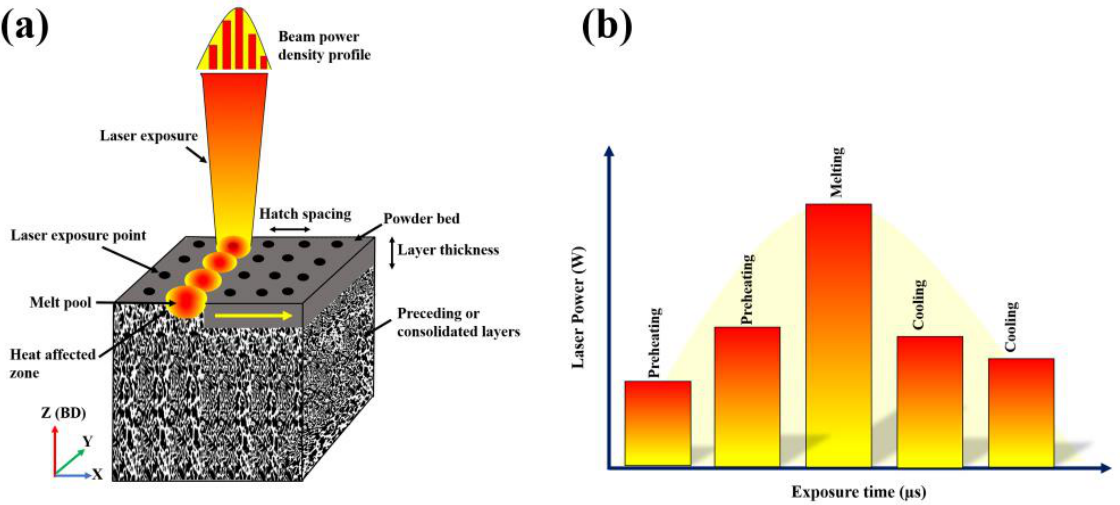
Figure 2. Schematics of the ( a ) SLM processing and laser exposure to powder bed, and ( b ) and single laser pulse to exposure point through pulse shaping technique.